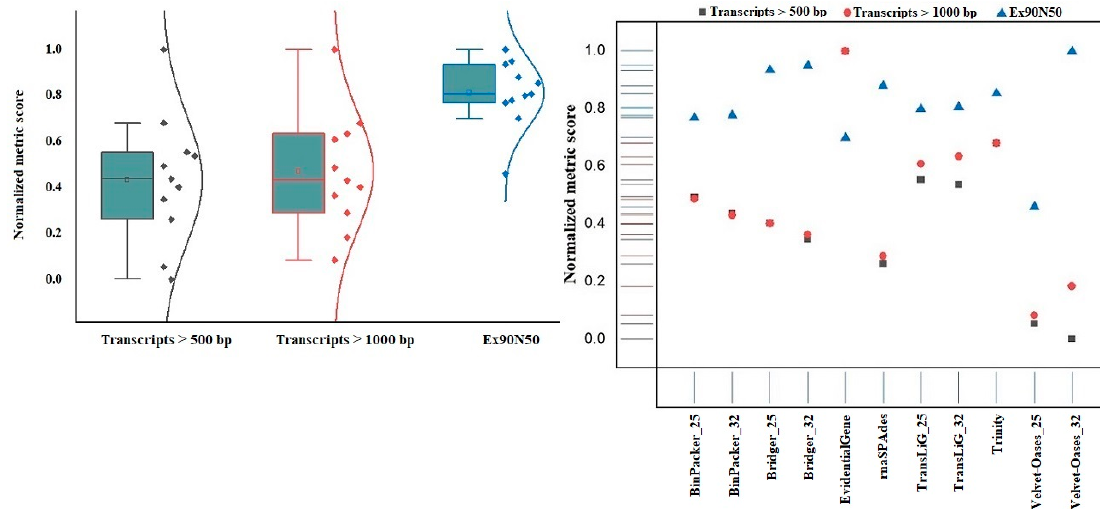
Figure 8. Normal distribution of the number of Transcripts > 500 bp, Transcripts > 1000 bp, and Ex90N50 values among